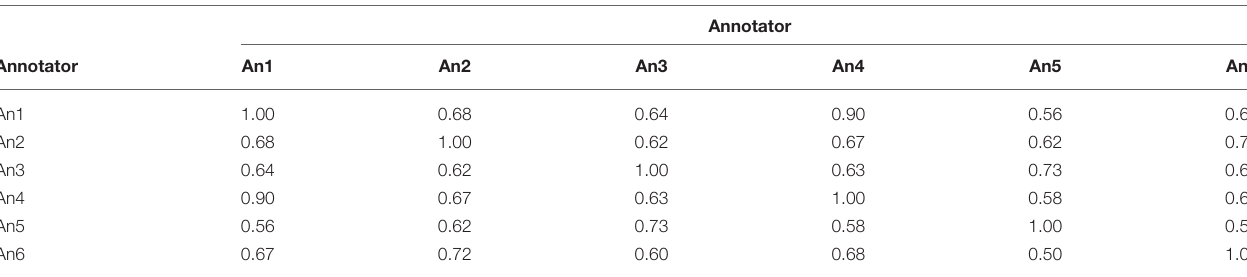
TABLE 10 | Pairwise Krippendorff’s α on the training